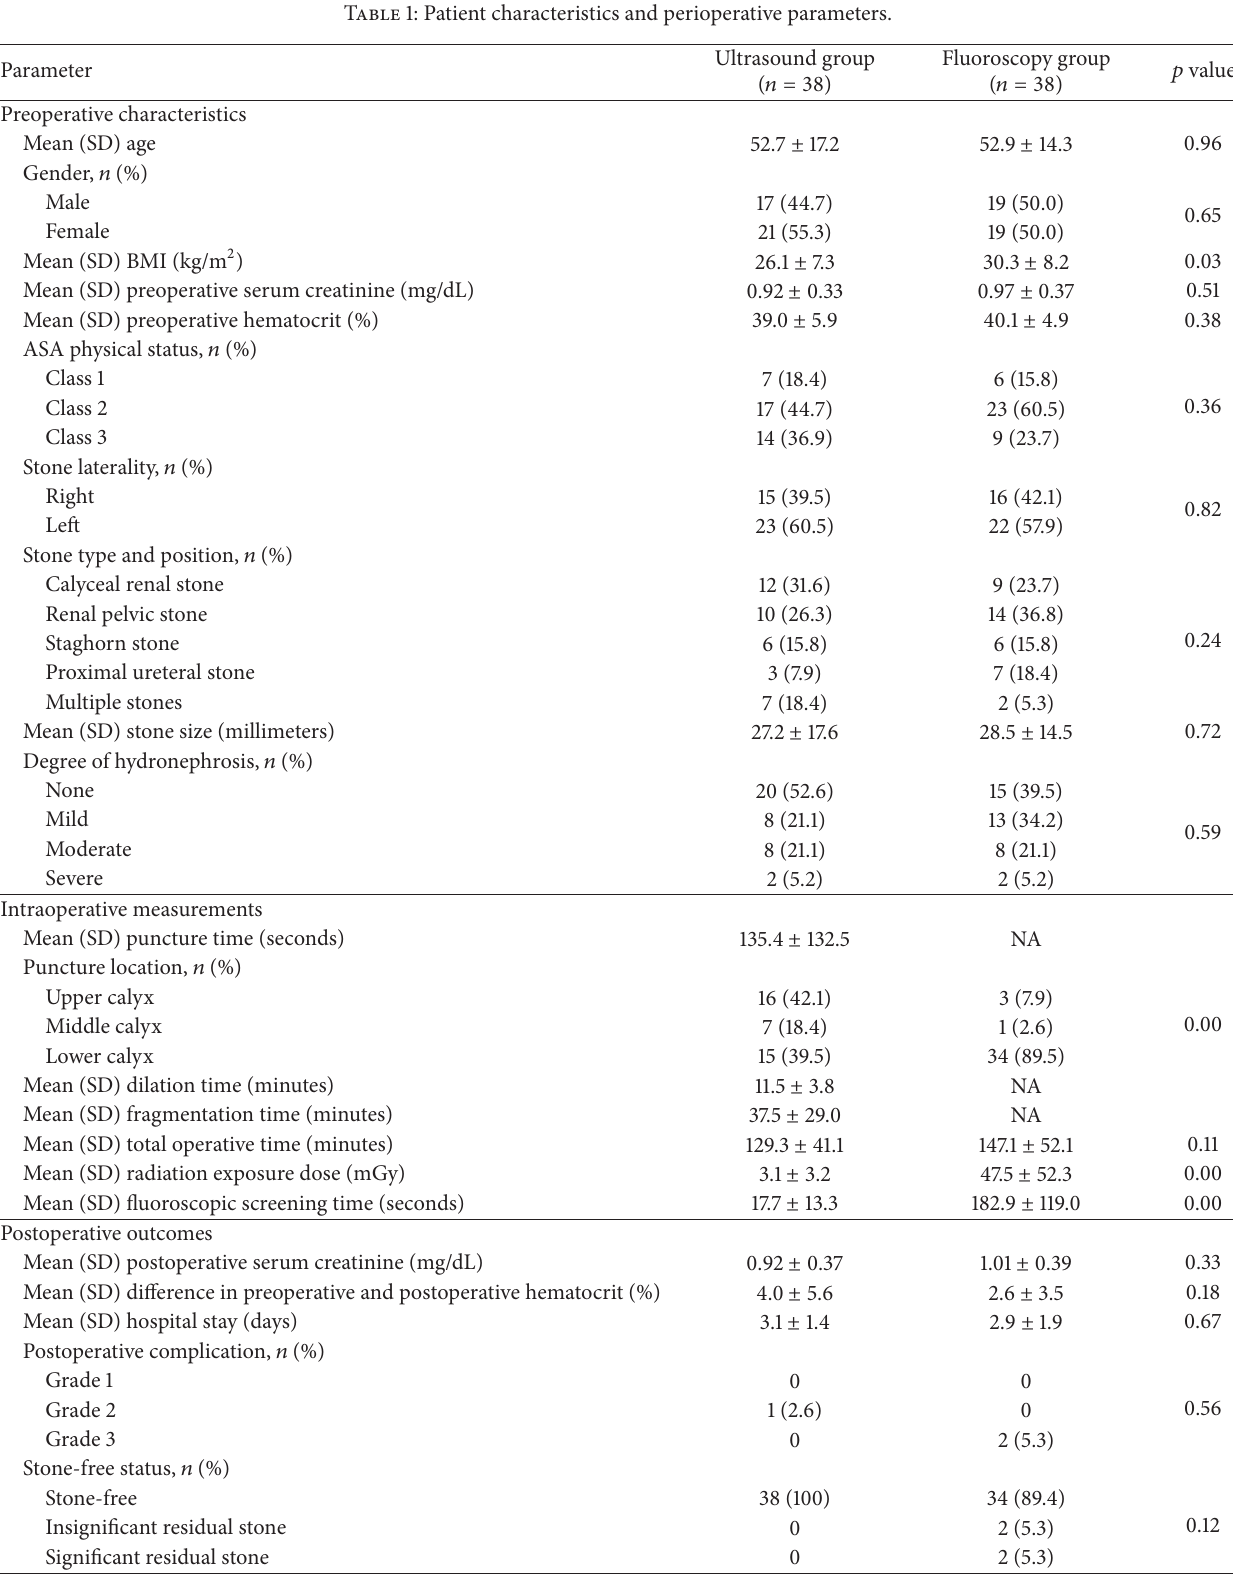
Table 1: Patient characteristics and perioperative